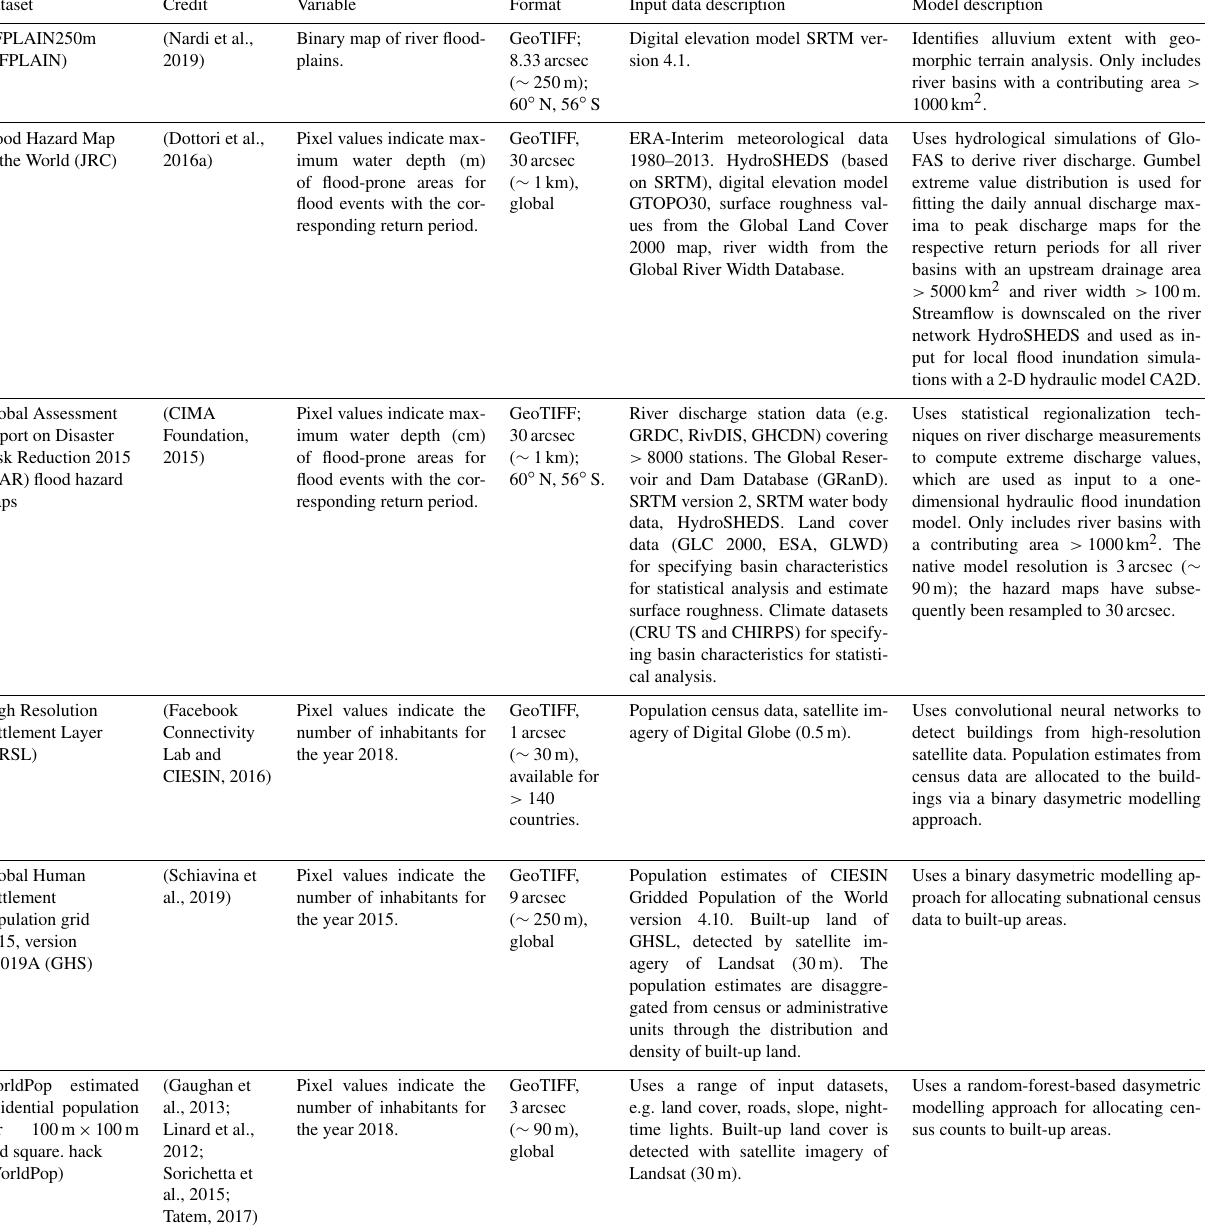
Table A1. A technical summary of the datasets used for riverine flood exposure